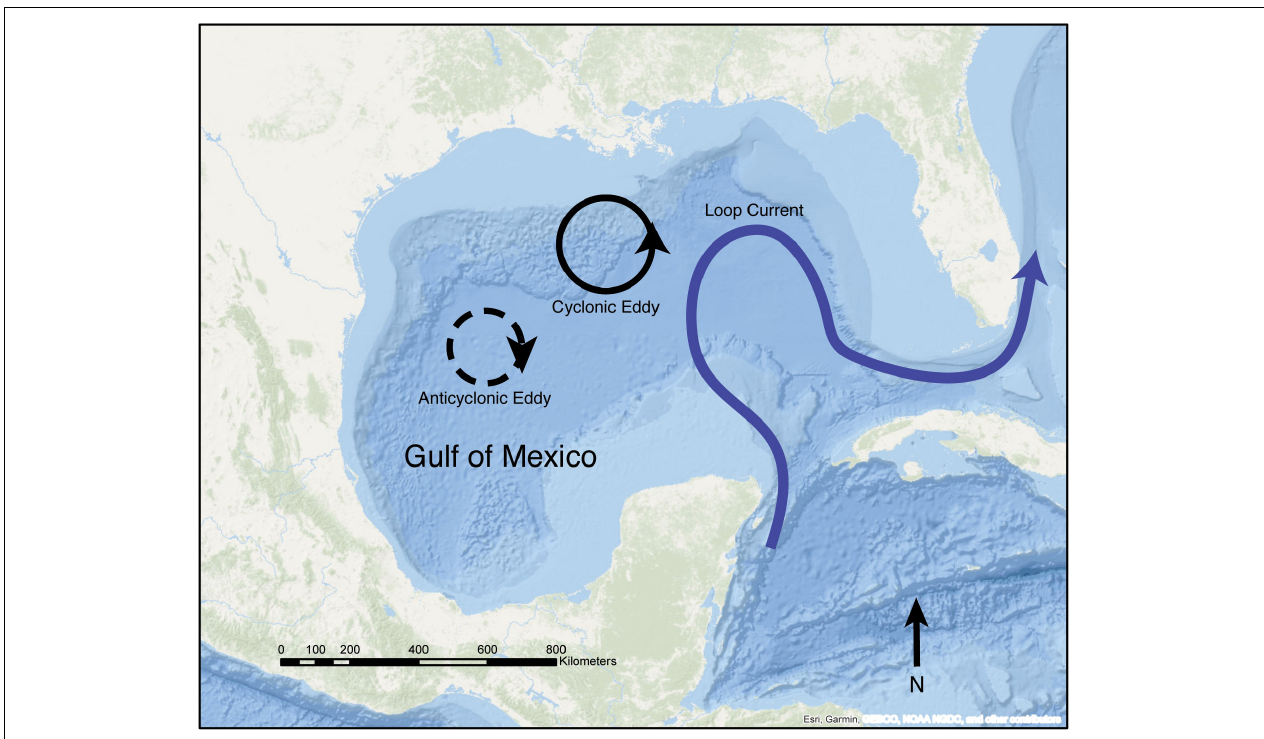
FIGURE 1 | Schematic of the GoM showing the Loop Current (blue) the FGB, and cyclonic and anticyclonic LCEs. The FGB are located on the Texas-Louisiana continental shelf in the NW GoM (Esri, 2019).